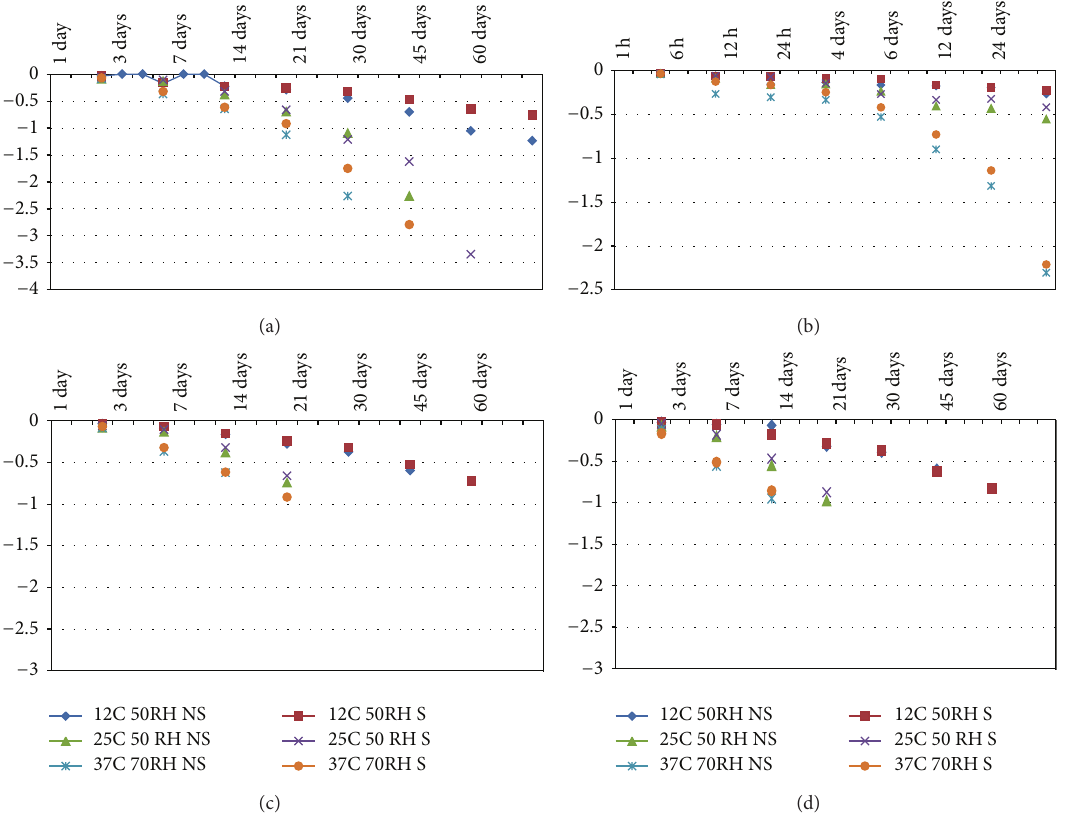
Figure 1: 𝐾 values for the first-order die-off rate of Giardia on (a) stainless steel, (b) skin, (c) formica, and (d) fabric.